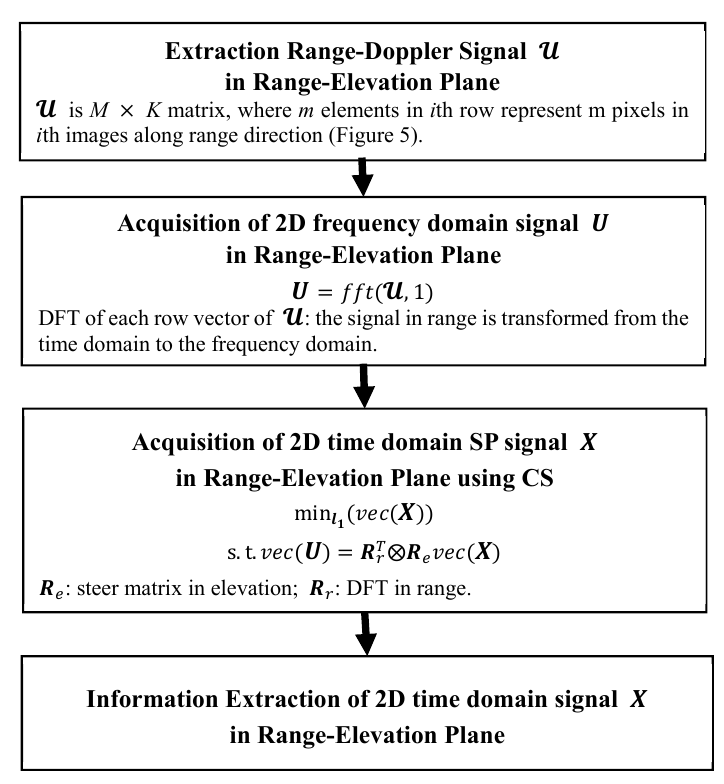
Figure 4. Flow diagram of compressive sensing-based two-dimensional range-elevation TomoSAR (CS 2D TomoSAR) method.